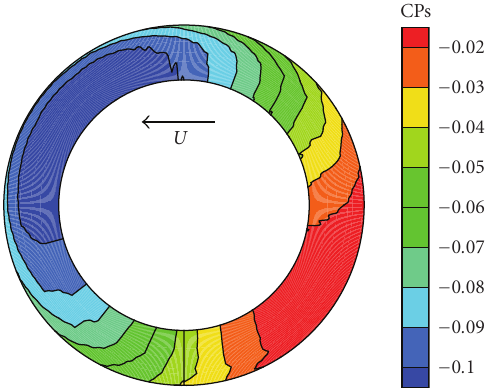
Figure 8: Static pressure coe ffi cient section e.